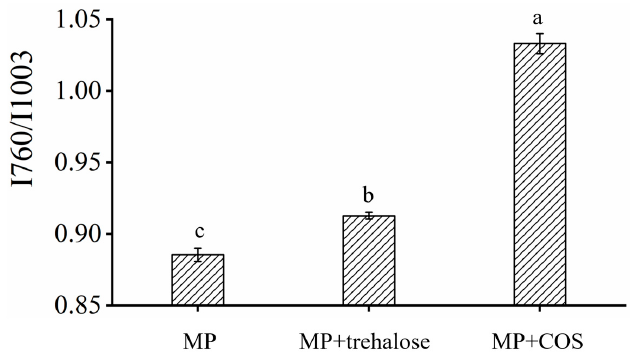
Figure 4. The normalized intensity of the I760/I1003 doublet bands of MP, MP + trehalose, and MP + COS. The letters (a–c) on the column indicate significant differences ( p < 0.05) between the data of different samples.